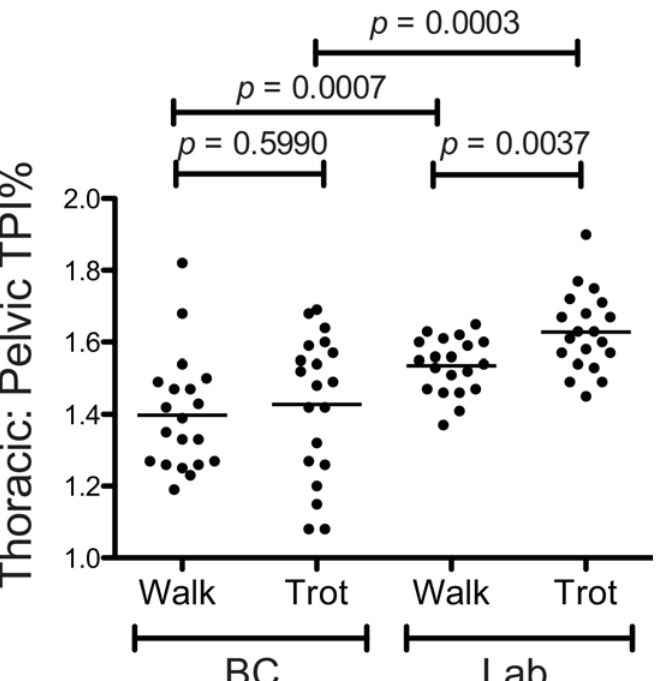
Fig 2. Thoracic to Pelvic Limb Total Pressure Index Percentage Ratio (T/P TPI%) at the Walk and Trot in Border Collies and Labrador Retrievers. The Border Collies had significantly lower ratios of weight borne on the thoracic vs the pelvic limbs (T/P TPI%) than the Labrador Retrievers at the walk (p = 0.0007) and at the trot (p = 0.0003). There was no difference in the relative weight borne on the thoracic vs. pelvic limbs of the Border Collies at the walk and trot (p = 0.5990), whereas the Labrador Retrievers bore more weight on the thoracic vs. pelvic limbs at the trot as compared to the walk (p =